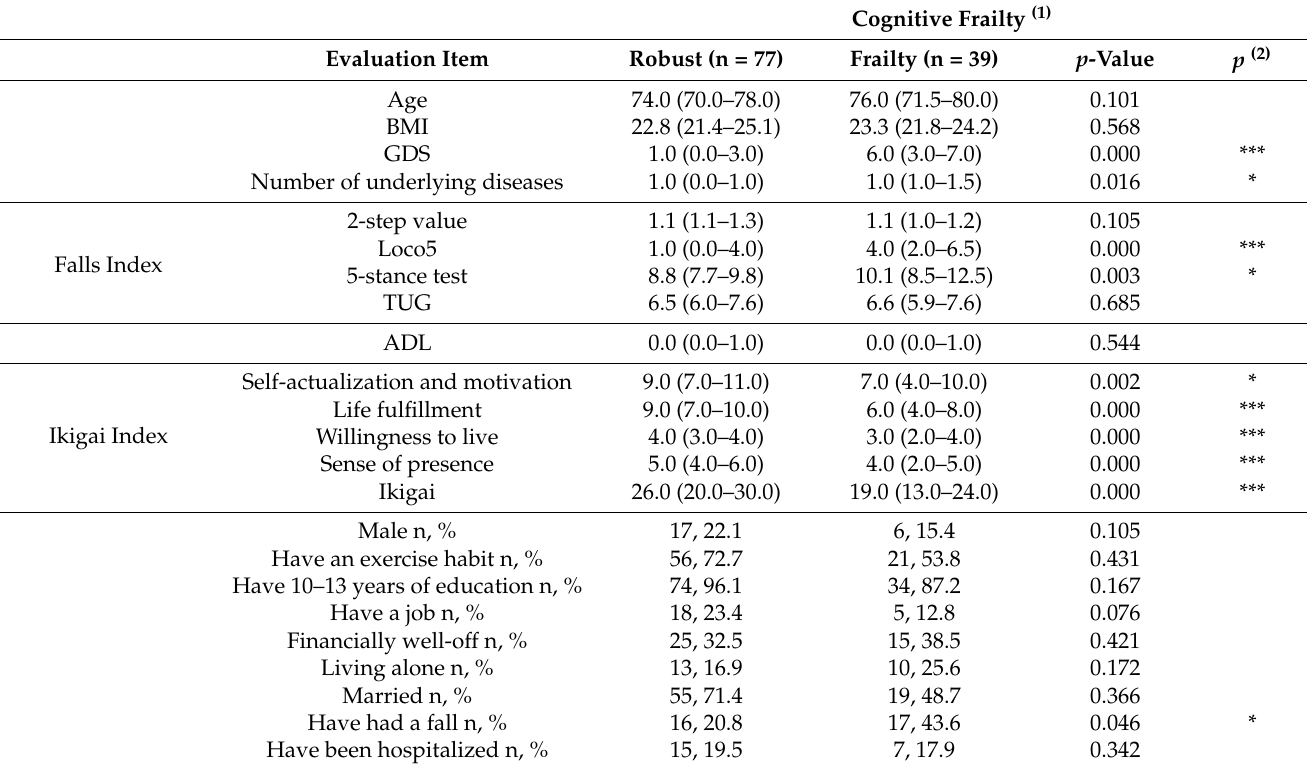
Table 3. Comparison of groups classified by cognitive